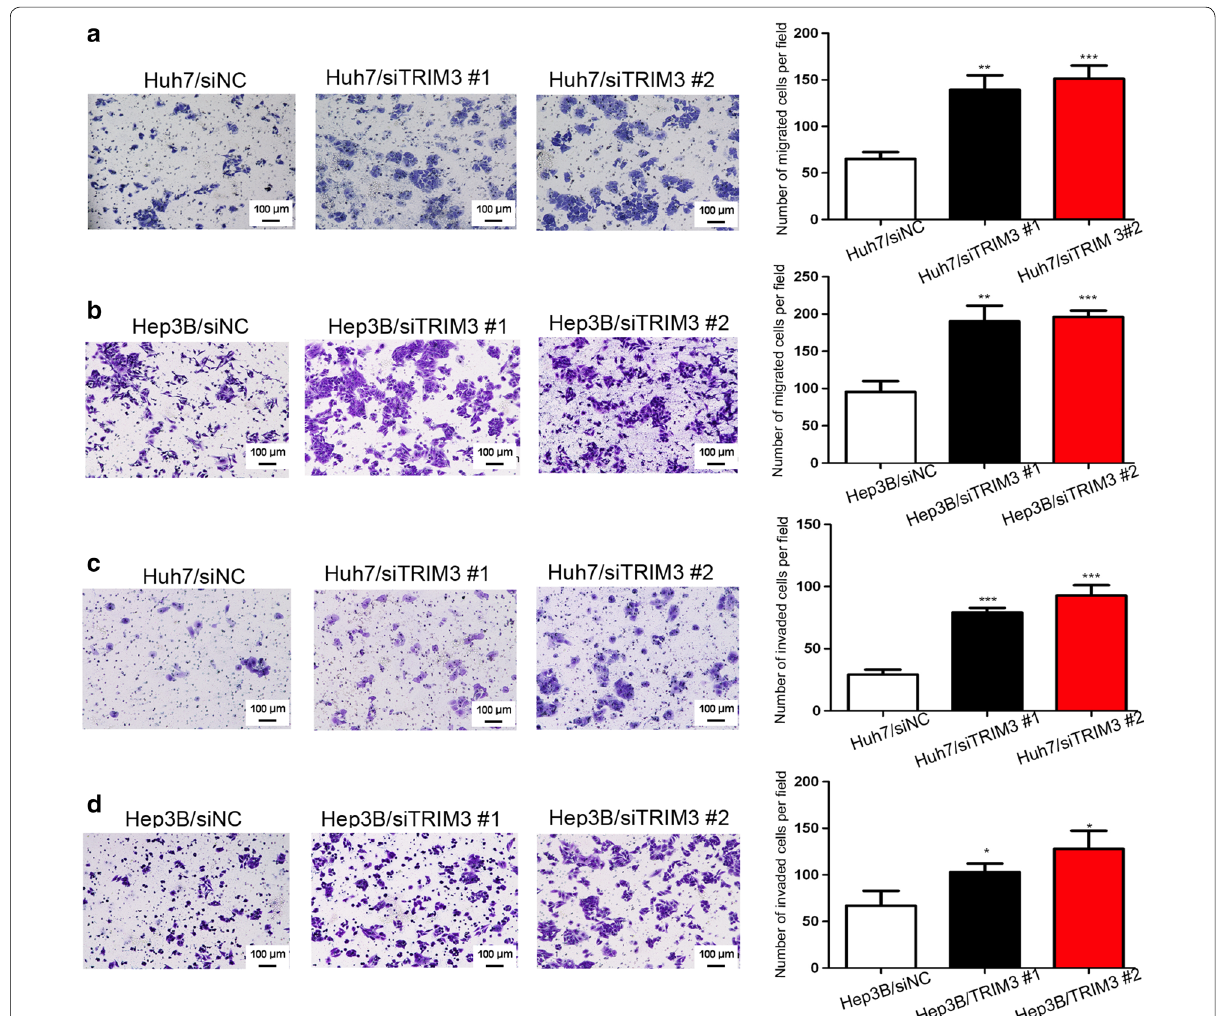
Fig. 7 Silencing TRIM3 promoted migration and invasion of Huh7 and Hep3B cells. Representative images of cell invasion and migration are shown on the left ( 100 magnification), and quantification of migrated or invaded cells in 10 randomly selected fields are shown on the right . a , b Silencing × TRIM3 promoted migration of Huh7 ( a ) and Hep3B ( b ) cells. c , d Silencing TRIM3 promoted invasion of Huh7 ( c ) and Hep3B ( d ) cells. Data are shown as mean SD of three independent experiments. P values were calculated using Student’s t test. * P < 0.05, ** P < 0.01, and *** P < 0.001, versus cells ± transfected with